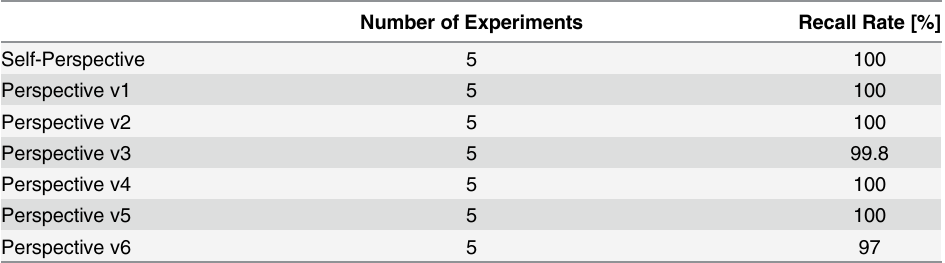
Table 2. Result of Associative